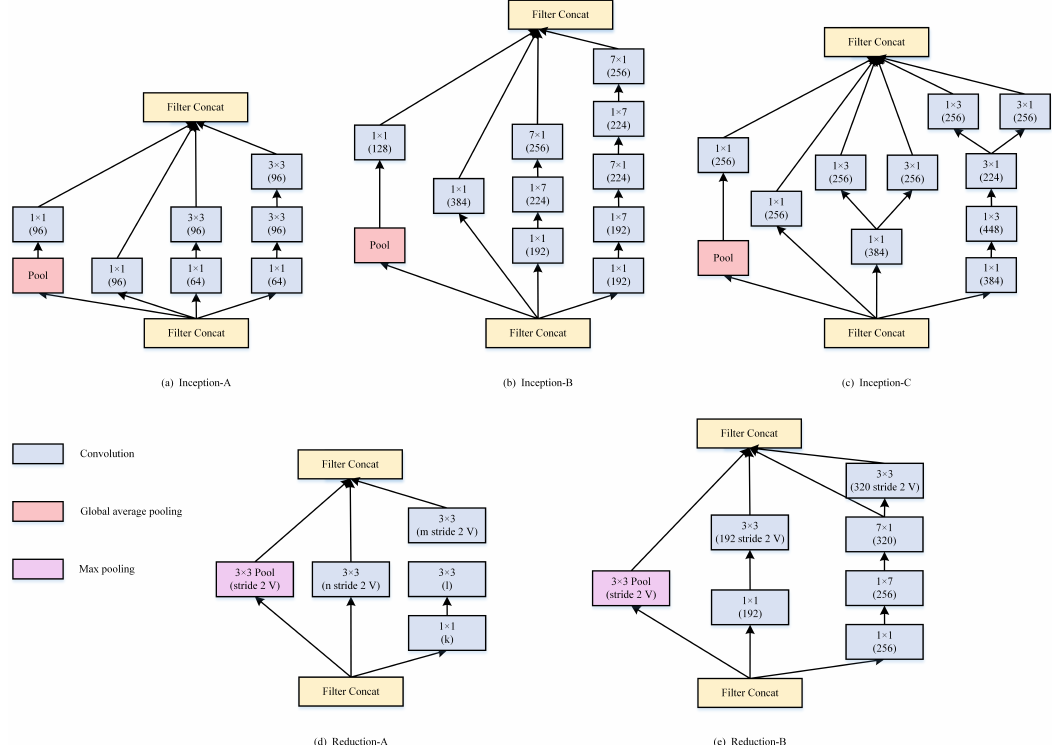
Figure 13. InceptionV4 blocks. It contains the Inception-A/B/C modules and Reduction-A/B